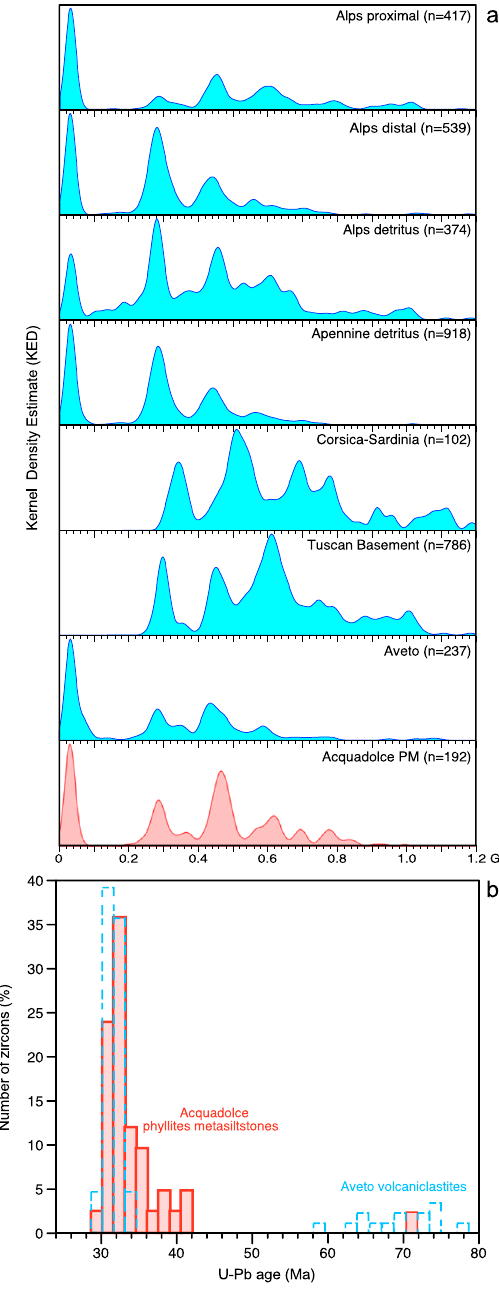
Figure 3. Comparison of the APM zircon age record with potential source regions. ( a ) Kernel Density Estimation (KDE 39 ) plots for potential sources of Cenozoic and pre-Mesozoic zircons: APM plot is compared with the age distributions from potential basement sources: proximal and distal successions of the Adria foredeep 22 , Corsica-Sardinia 33 , Tuscan basement 10,17 , modern rivers draining the western-central-southern Alps and the northern Apennines 34 , volcaniclastic detritus of the Aveto unit 18 . ( b ) Comparison of the Cenozoic zircon age distributions of the APM and Aveto fm 18